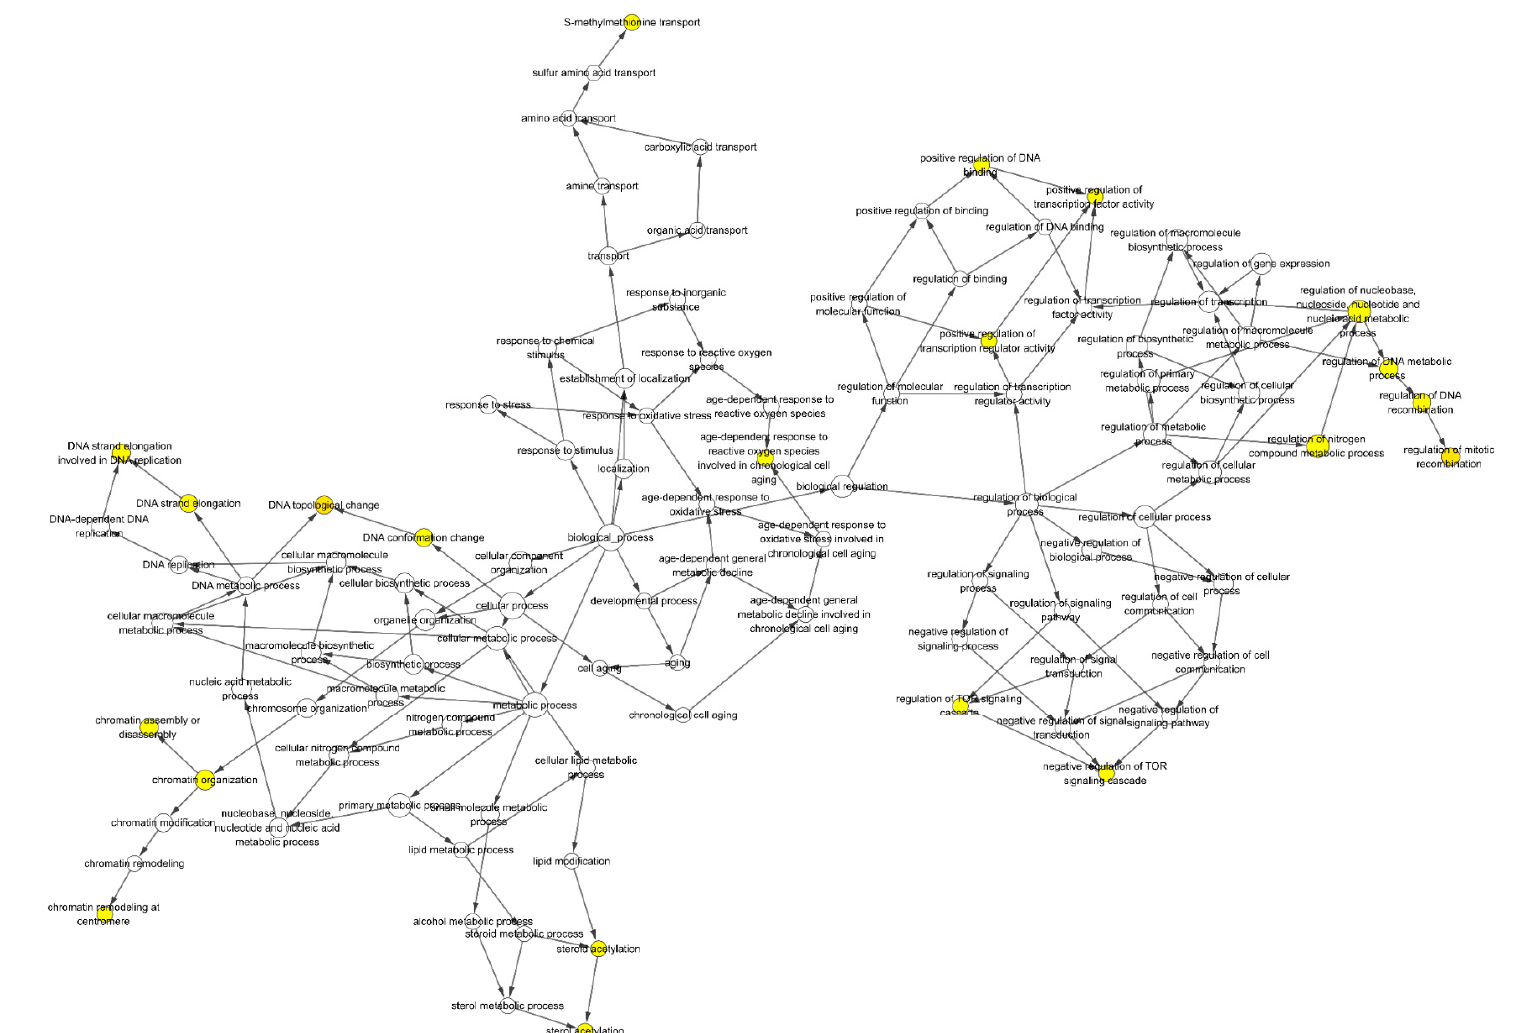
Figure 5. The biological process of HDW. Yellow circles represent the biological processes with adjusted p -values <0.05.